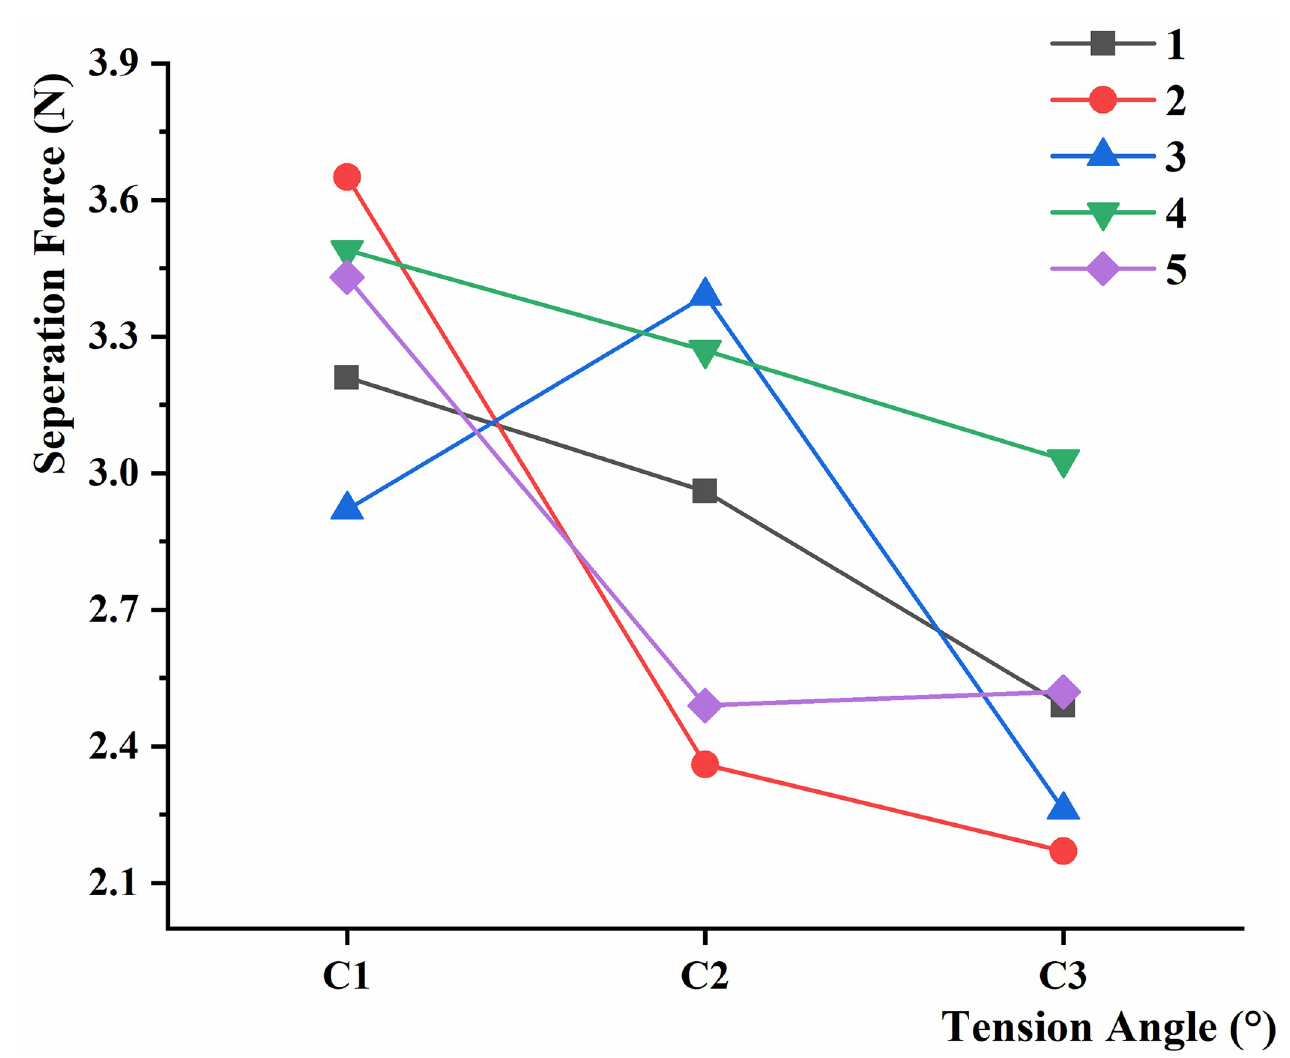
Fig 14. Separation force between black fungus and the sticks at different tension